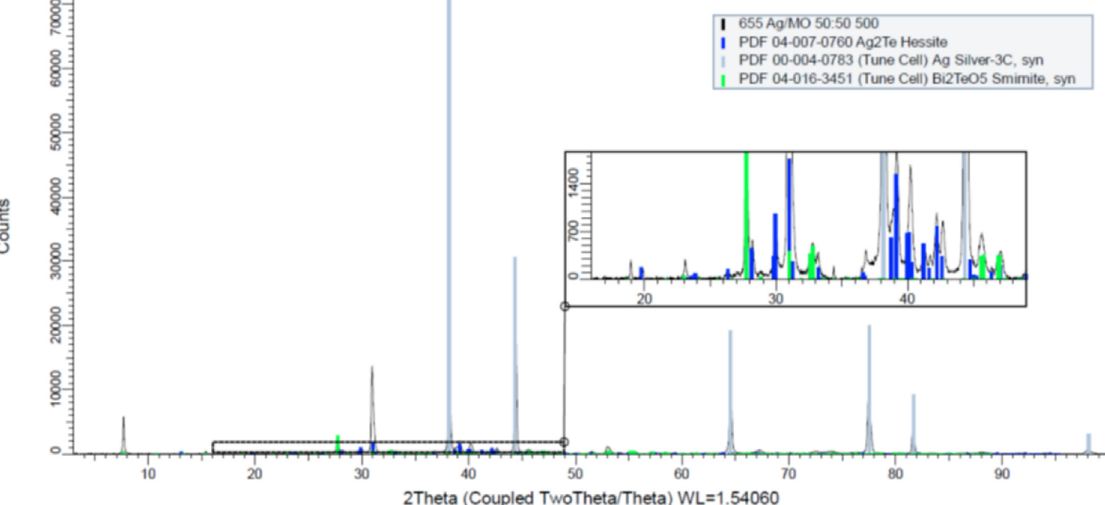
Fig. 6. XRD measurement of the RTP fi ring sample (peak temperature 500 ° C) with an Ag:MO ratio of 50%:50%. The counts are shown depending on the 2 u angle, with a zoom on the area of interest. With dark blue, the peaks corresponding to Ag 2 Te in hessite structure, in grey silver and in green the Bi 2 TeO 5 are identi fi